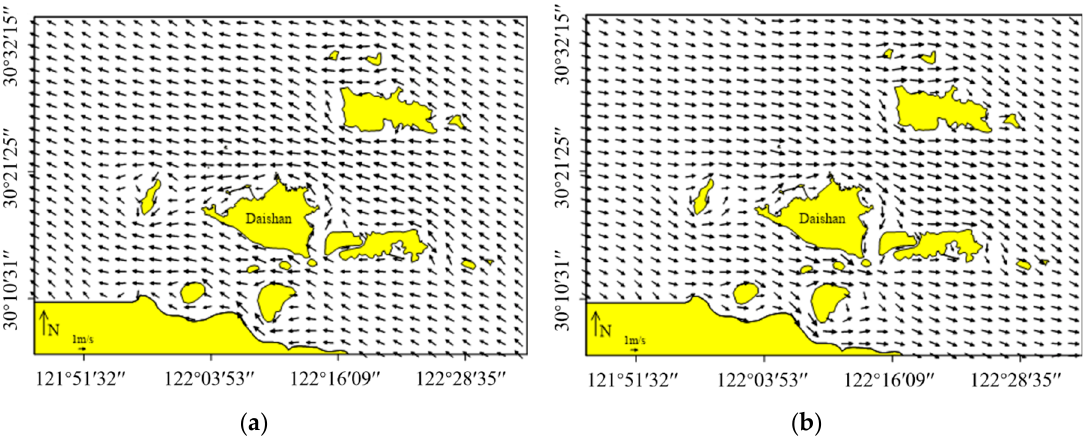
Figure 6. Rapid flow chart of tidal fluctuation. ( a ) Flood tide, ( b ) Ebb tide.